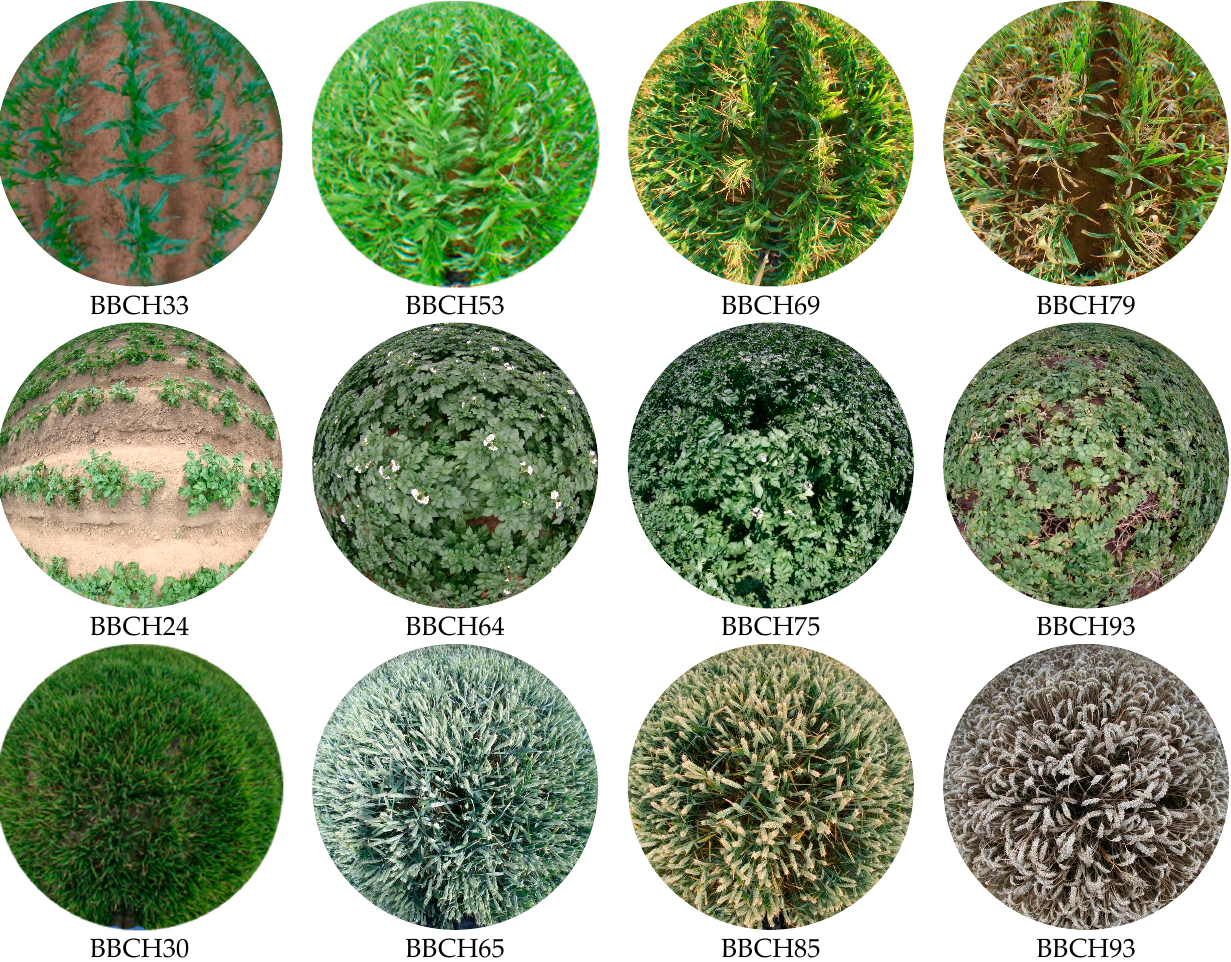
Figure 5. Examples of Digital Hemispherical Photos (DHP) and BBCH code for maize (top); potato (middle); and, winter wheat (bottom). An overview of BBCH codes for the different crops is provided in [49].